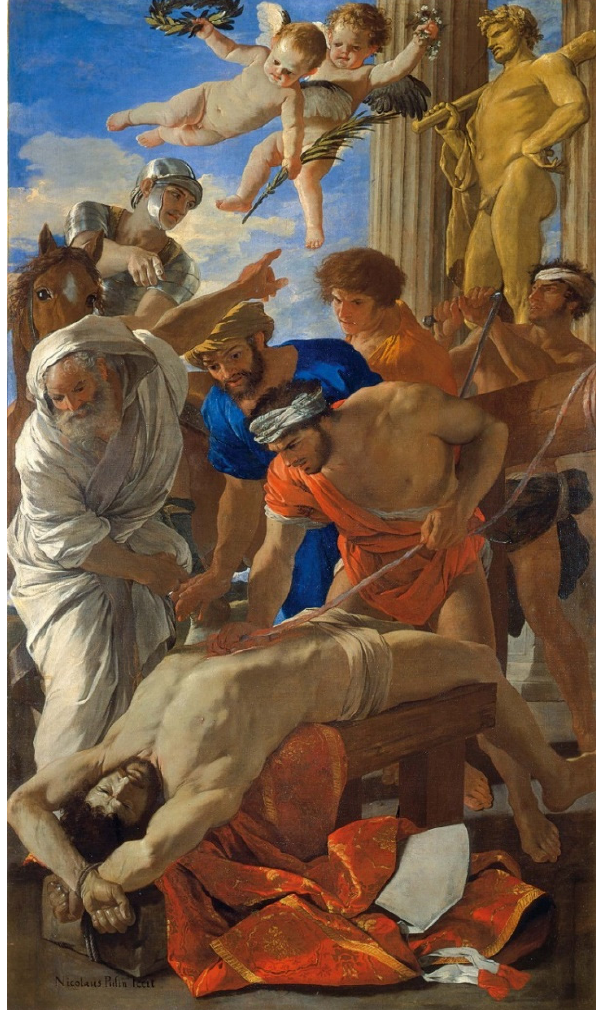
Figure 7. Nicolas Poussin. The Martyrdom of Saint Erasmus , 1628–29. Vatican Pinacoteca.